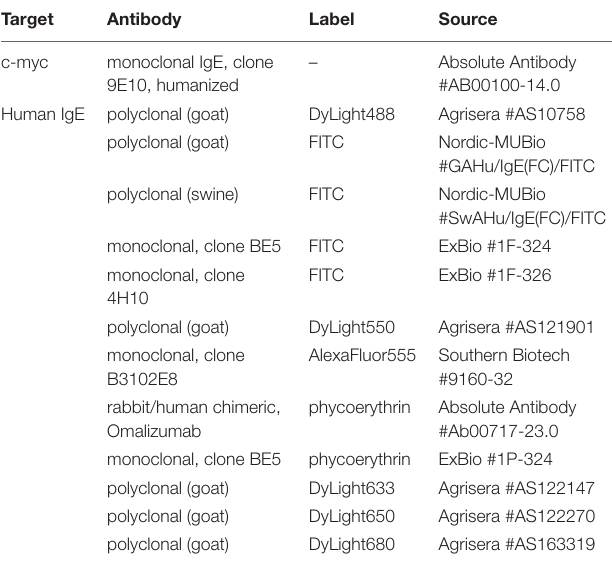
TABLE 1 | Commercially available antibodies used in this